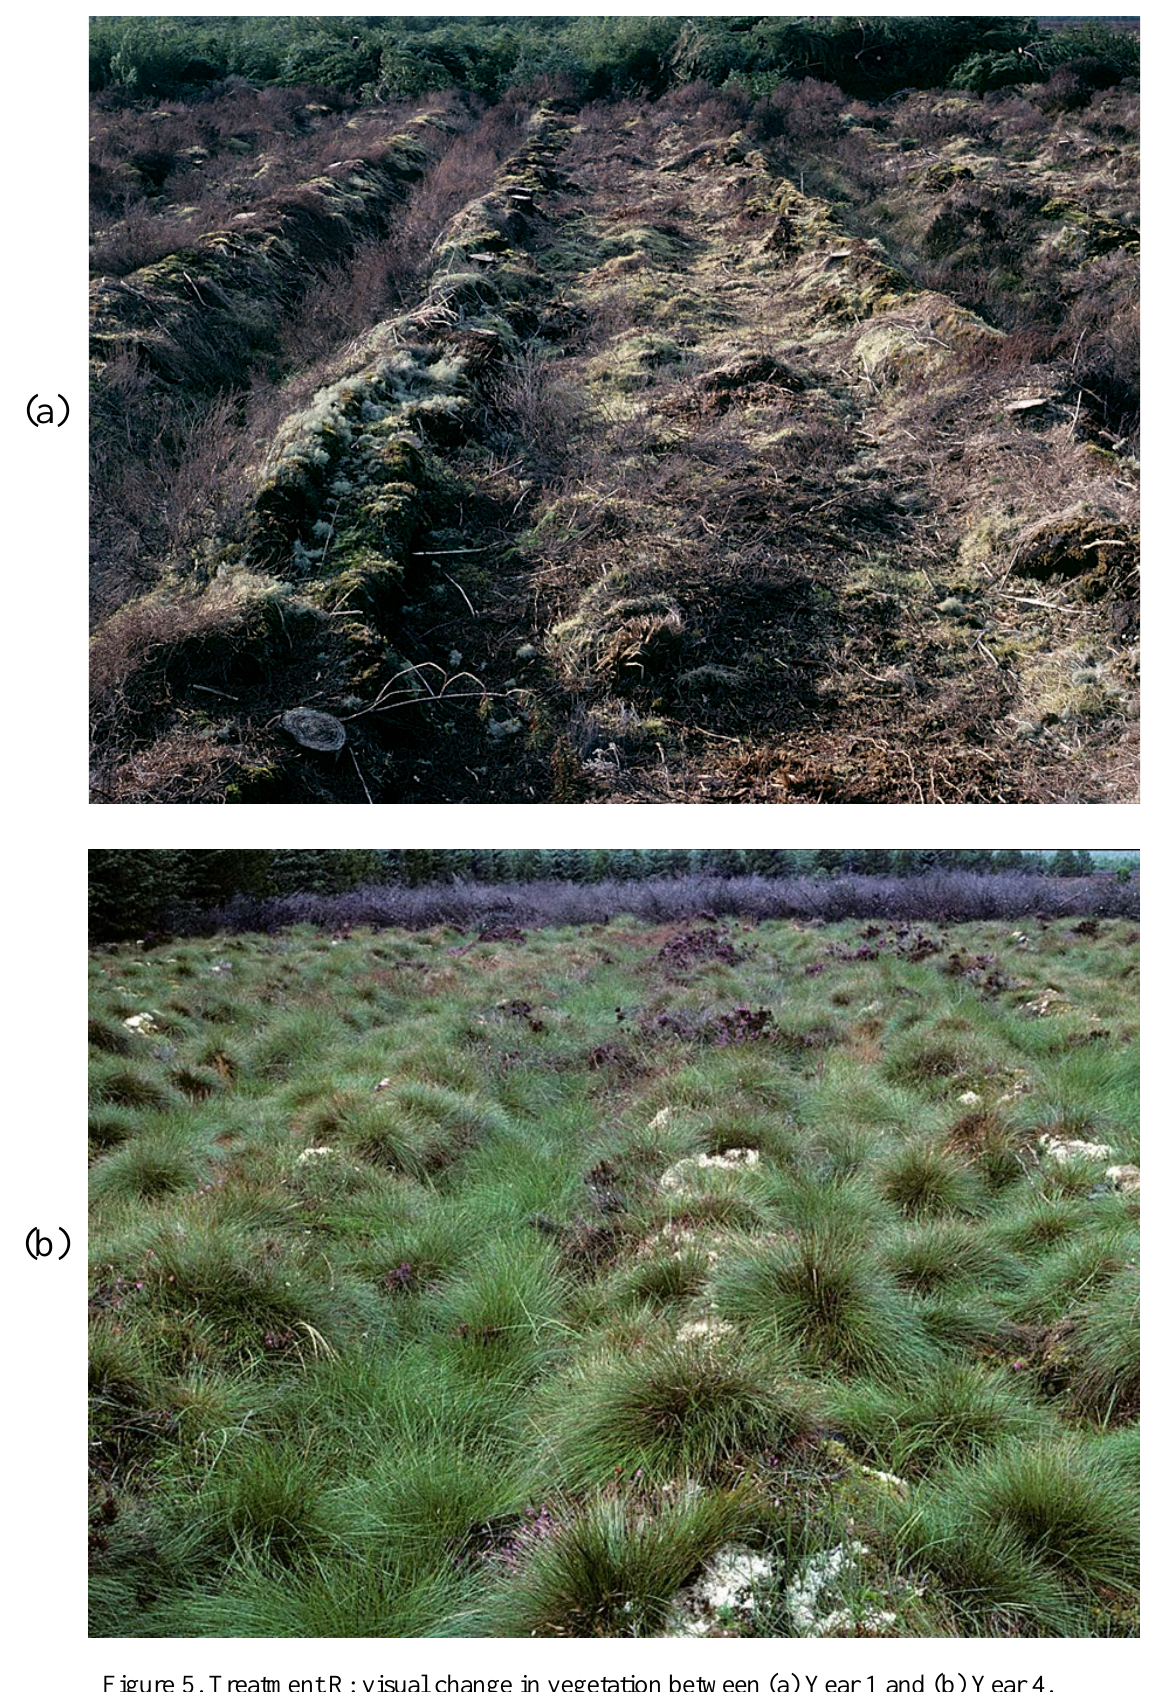
Figure 5. Treatment R: visual change in vegetation between (a) Year 1 and (b) Year